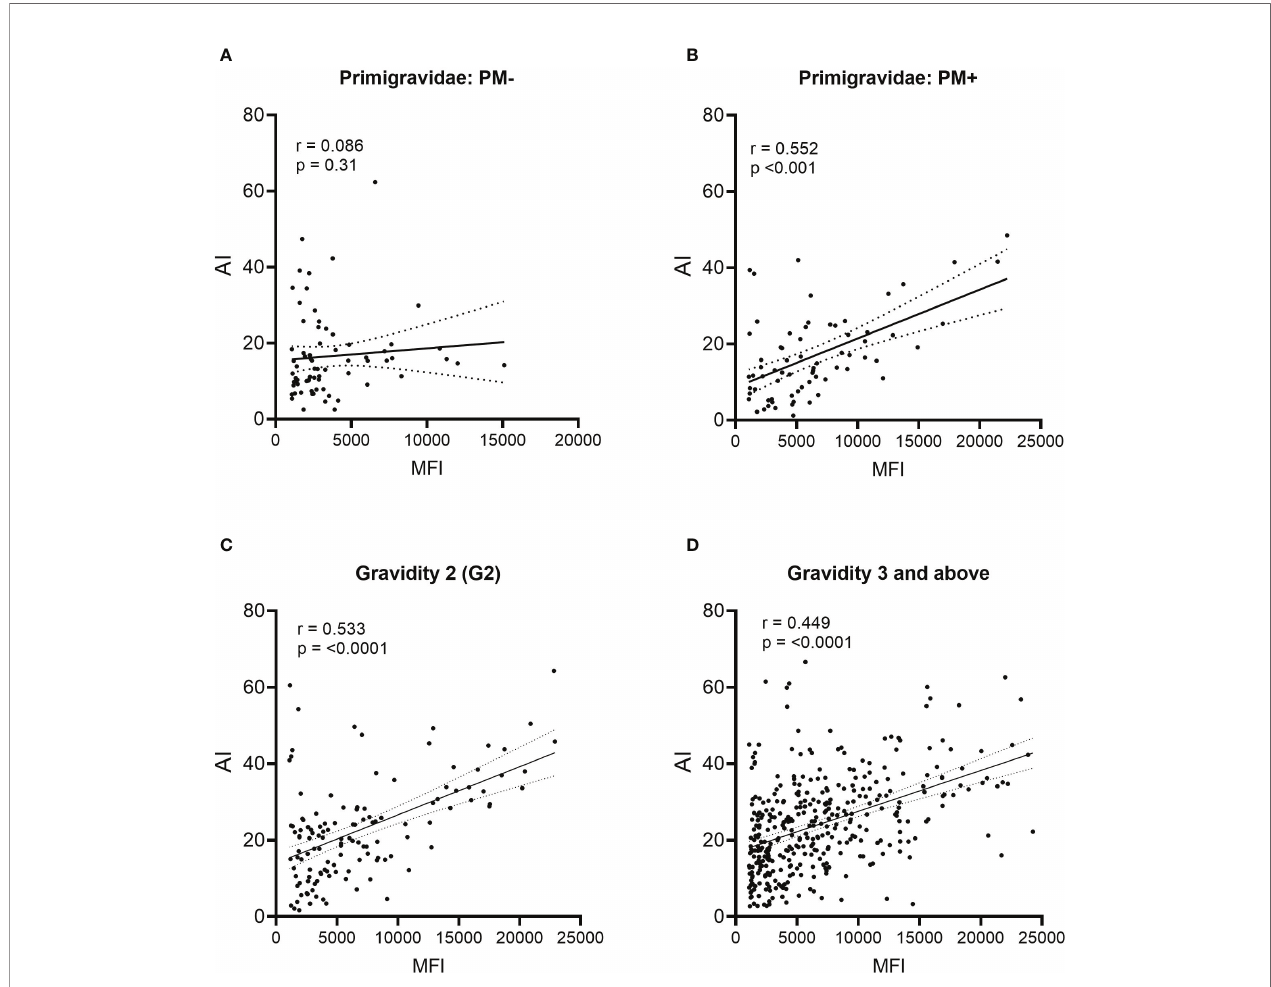
FIGURE 6 | Comparison of Ab levels (MFI) and avidity (AI) using linear regression. (A) Placental malaria-negative (PM − ) primigravidae (n = 71), (B) Placental malaria- positive (PM+) primigravidae (n = 70); (C) all secundigravidae (G2) (n = 127); and (D) all women gravidity 3 (G3) and above (n = 373). Linear regression lines with 95% con fi dence bands are shown. P values indicate if the line is signi fi cantly different from